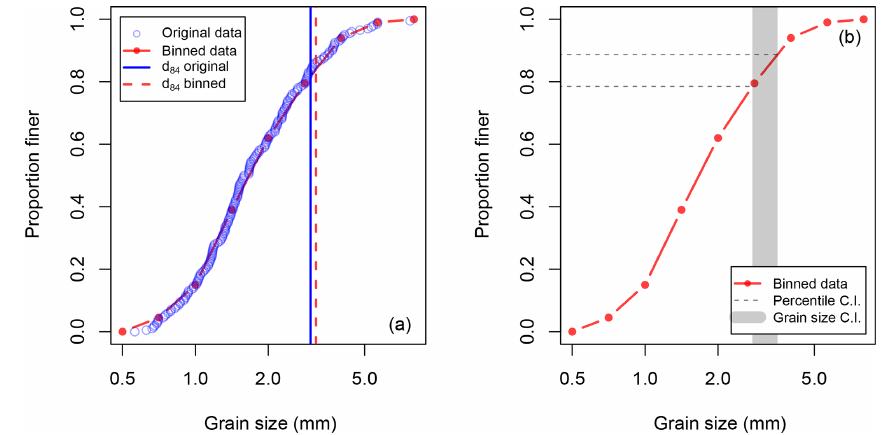
Figure 3. A grain size distribution from a stream table experiment based on a sample size of 200 observations. In panel (a) , blue circles indicate individual grain size measurements ( d ( i ) ) and the red line is the cumulative frequency distribution for binned data using the standard 0.5 φ bins. In panel (b) , the interpolated upper and lower percentile confidence bounds for the binned data are shown as horizontal lines, and the associated 95% grain size confidence interval containing the true D 84 for the population is shown in grey.